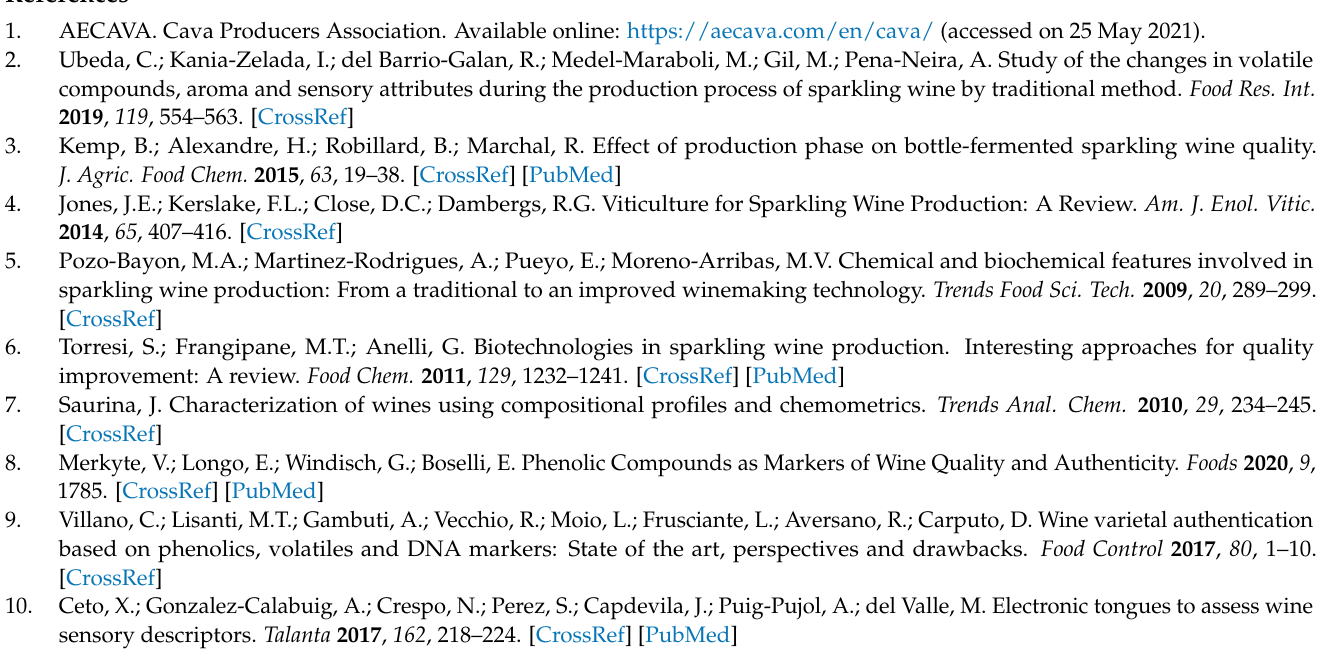
HPLC methods. Table S3: Average, standard deviation, RSD (%), and maximum and minimum values from FTIR, potentiometric, and volumetric methods in the set of samples under study. Table S4: Summary of classification results by PLS-DA for the assignation of white, blanc de noirs, and ros é cava samples. Figure S1: PCA results showing the biplot of PC1 vs. PC2 from the study of FTIR data. Plot of scores (a) and plot of loadings (b). Cava class assignation: see Table 1. Figure S2: Classification plots from PLS-DA. Sample assignation: triangle = white; square = ros é ; circle = blanc de noirs; empty symbols = calibration samples; solid symbols = validation samples. Red line indicated the classification